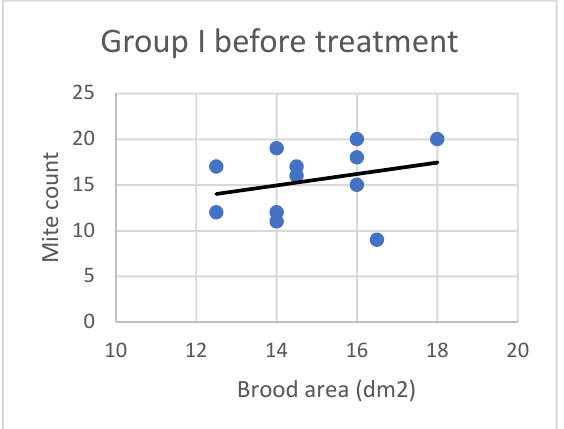
Figure 1. Linear regression plots of brood area (fixed factor) and mite counts in Group I before treatment.